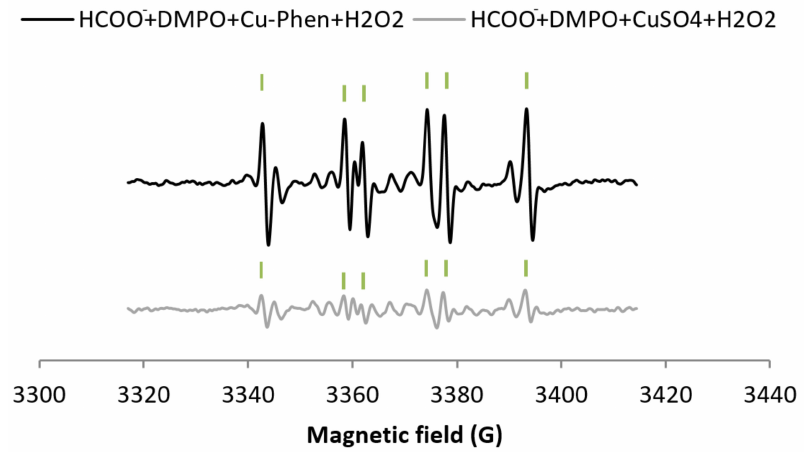
Figure 6. Comparison between the X-band EPR spectra of HCOO − + DMPO + Cu–Phen + H 2 O 2 (exp 5) and HCOO − + DMPO + CuSO 4 + H 2 O 2 (exp 10) - Assignments: | = DMPO–COO − .